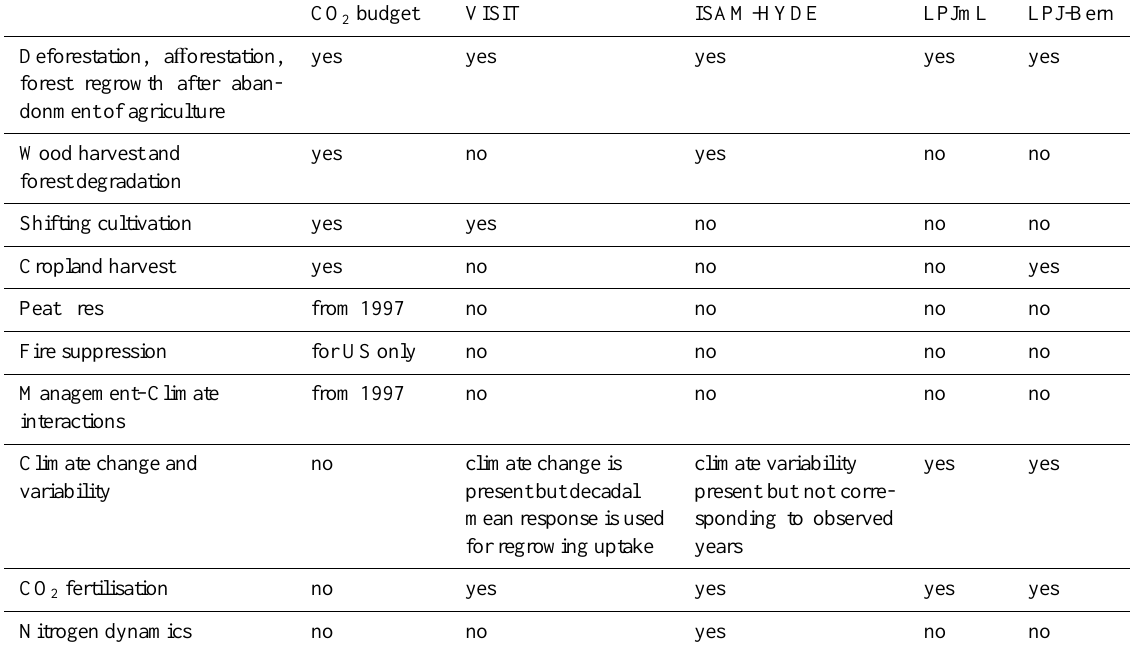
Table 2. Comparison of the processes included in the E LUC of the global carbon budget and the DGVMs. See Table 3 for model references. CO 2 budget VISIT ISAM-HYDE LPJmL LPJ-Bern yes Deforestation, a ff orestation, forest regrowth after aban- donment of agriculture Wood harvest